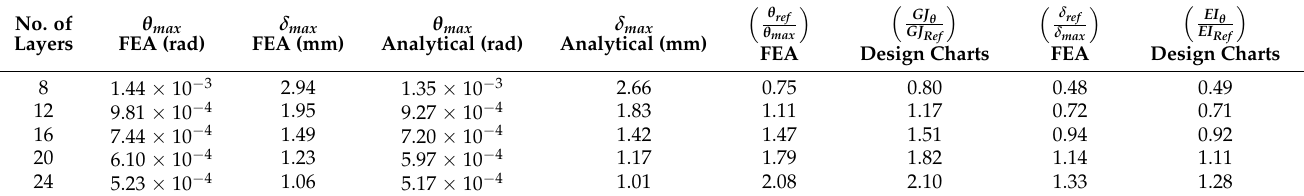
Table 3. Bending and torsional results obtained using analytical and FEA approaches (FD = 20 ◦ ). θ max No. of FEA Layers